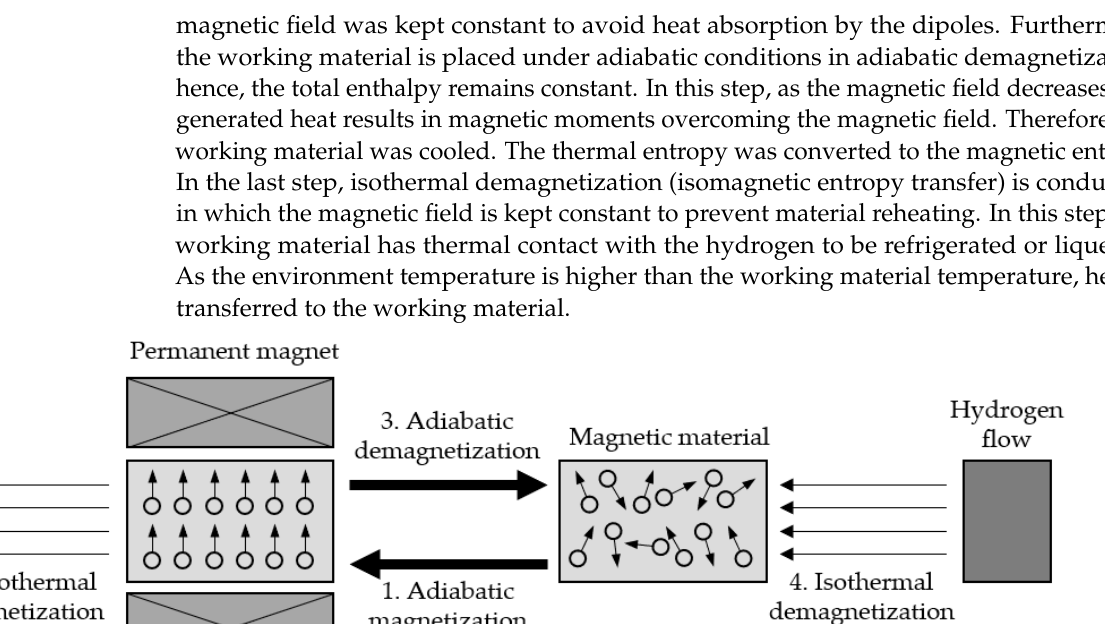
13 of 31 Figure 8. Basic schematic diagram of Brayton cycle for hydrogen liquefaction: ( a ) simple helium Brayton cycle; ( b ) helium Brayton cycle with liquid nitrogen pre-cooling, and ( c ) two-step helium Brayton cycle [67]. 3.5. Magnetic Refrigeration/Liquefaction System Magnetic refrigeration utilizes a magnetic field to both magnetize and demagnetize the magnetic material repeatedly, resulting in a magnetocaloric effect. Therefore, a low temperature of heat can be produced owing to this magnetocaloric effect [72]. The mag- netocaloric effect is a phenomenon in which a change in the magnetic field results in a reversible change in the working material temperature. The first magnetic refrigerator was initially developed in 1930 [73]. Furthermore, a near room temperature magnetic re- frigerator was successfully developed in 1976 by Brown [74]. By using gadolinium and changing the magnetic field (0–7 T), Brown successfully realized a 47 K no-load tempera- ture difference between hot and cold ends (temperatures of 319 and 272 K, respectively) [74]. Gadolinium alloys have been broadly adopted as working magnetic materials, alt- hough some other promising materials have also been developed and evaluated [75]. Figure 9 shows a schematic diagram of the magnetic hydrogen liquefaction. Magnetic refrigeration principally adopts the reversed Carnot cycle and consists of four continuous